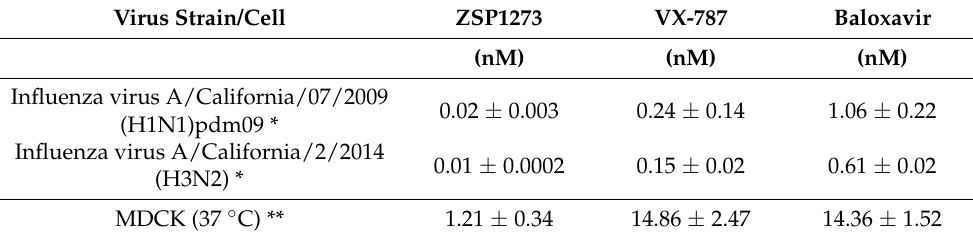
Table A5. Inhibitory activity of ZSP1273 against influenza virus strains (H1N1 and